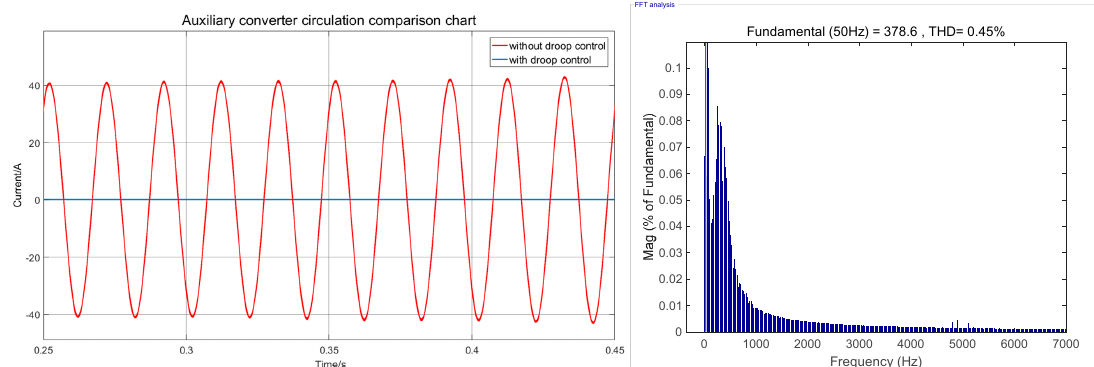
Figure 14. Power supply system step-by-step simulation results.